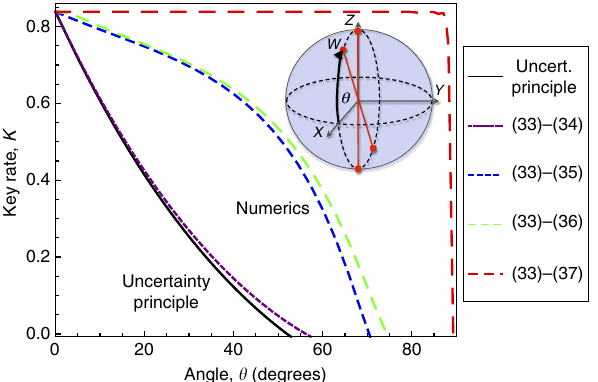
Figure 5 | Protocol where Alice and Bob each measure Z or W . Here Z is the standard basis and the W basis is rotated by an angle y away from the X basis. The key rate versus y is shown with the error rate set to Q ¼ 0.01. Our numerics give a hierarchy of four lower bounds on the key rate, corresponding to adding in additional constraints from (33)–(37).